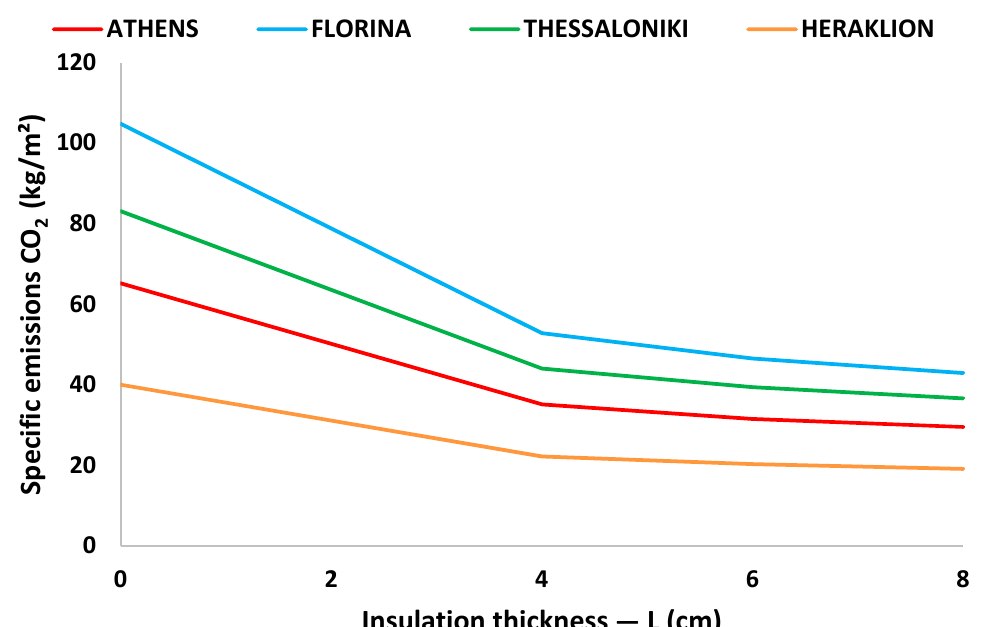
Figure 6. Specific carbon dioxide emissions for the examined cases.